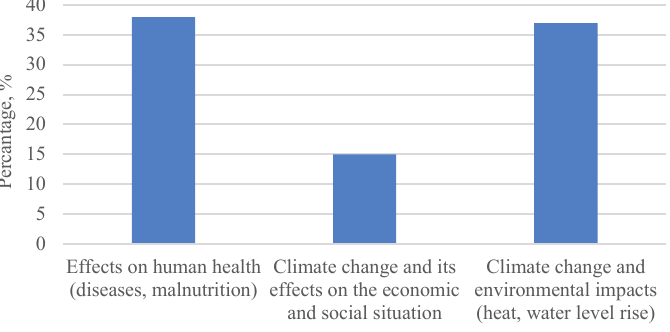
Fig. 4. Reasons why the problem seems